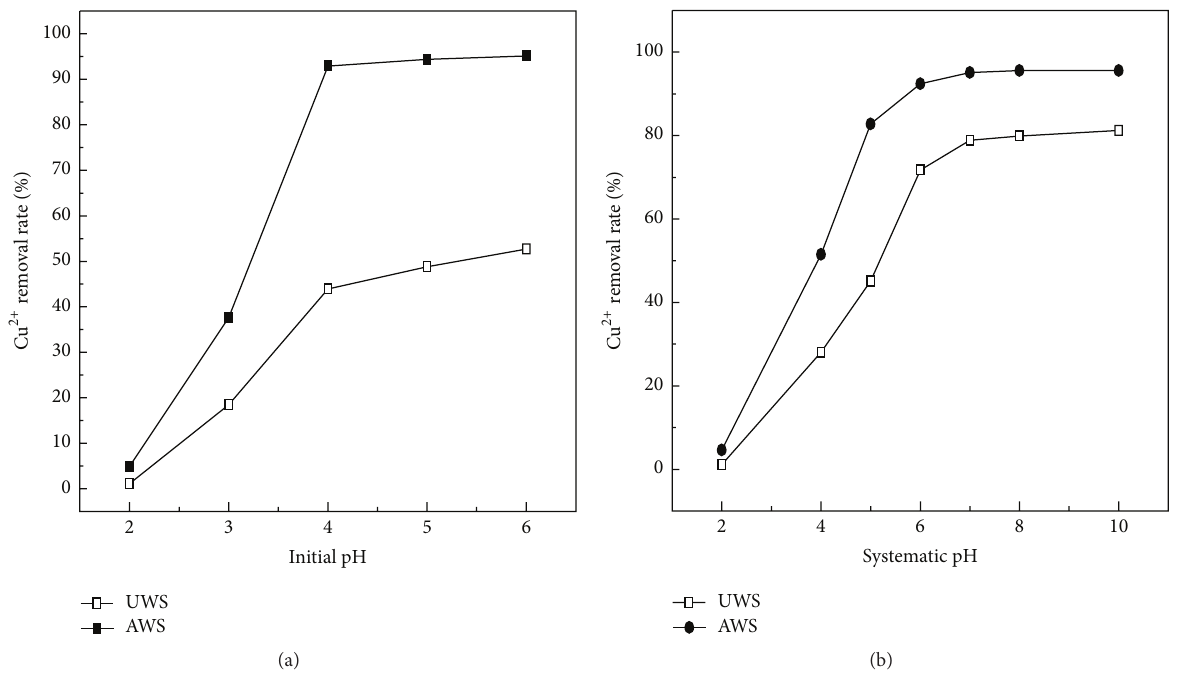
Figure 4: Effect of initial and systematic pH (conditions: adsorbent dose = 5g/L, adsorbate conc. = 20 mg/L, contact time = 6 h, temp. = 25 ± 1 ∘ C, and stirring rate = 150